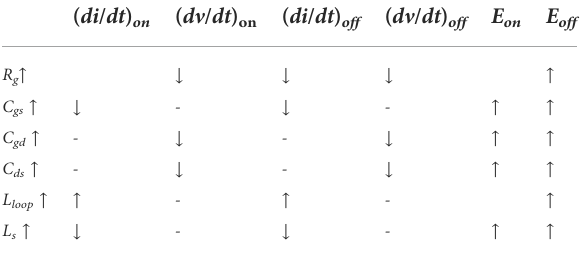
TABLE 1 Comparison of key parameters between the SiC MOSFET and Si IGBT.